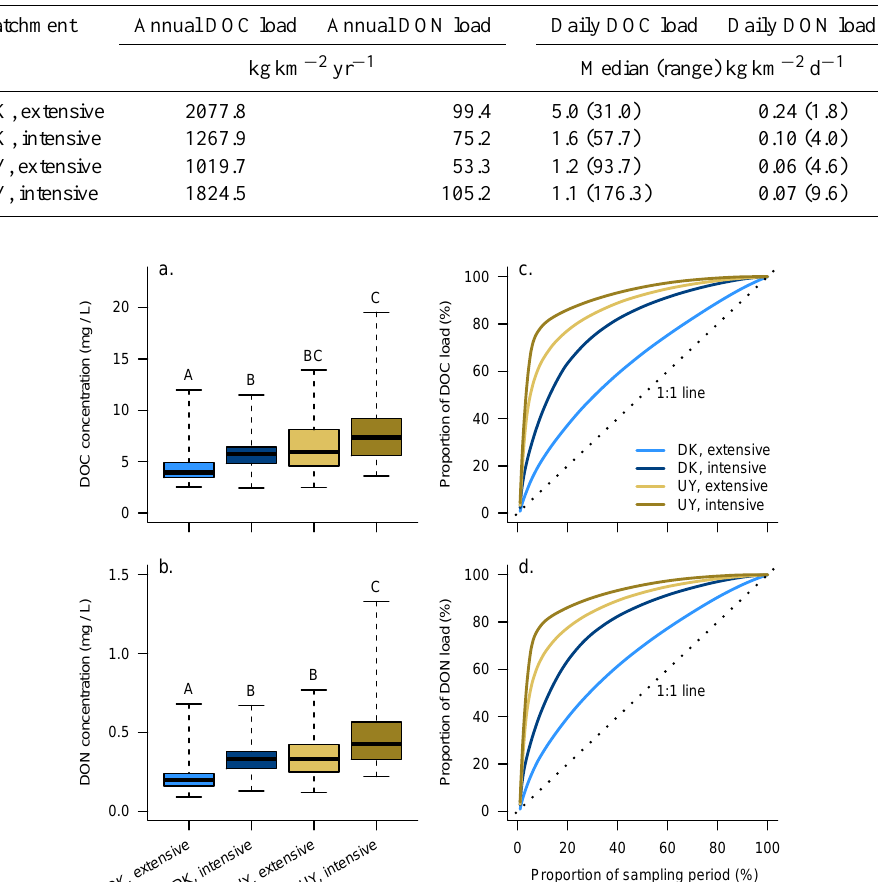
Figure 2. Concentrations (a, b) and ranked daily load versus the proportion of the sampling period ( c and d , plot style adapted from Dalzell et al., 2007) for dissolved organic carbon (DOC) and dissolved organic nitrogen (DON). The 1:1 line in (c) and (d) represents a completely equal DOC and DON load across the whole sampling period. Capital letters indicate significantly different groups ( p < 0.05, Nemenyi pairwise test, n was 47–49, depending on the stream). DK: Denmark, UY:Uruguay, extensive: extensive farming, intensive: intensive